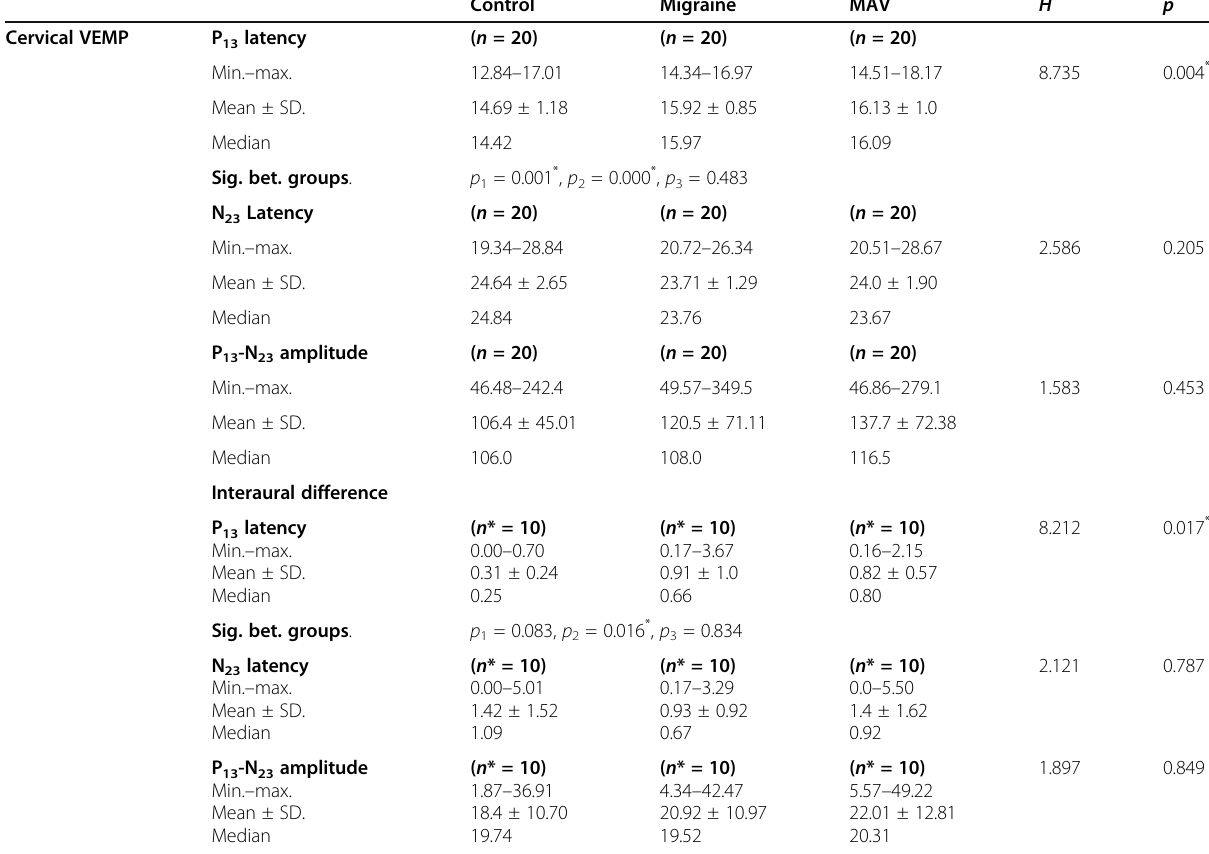
Table 1 Cervical VEMP P 13 , N 23 latencies (in ms), P 13 -N 23 amplitude (in μ V), and IAD in the three studied